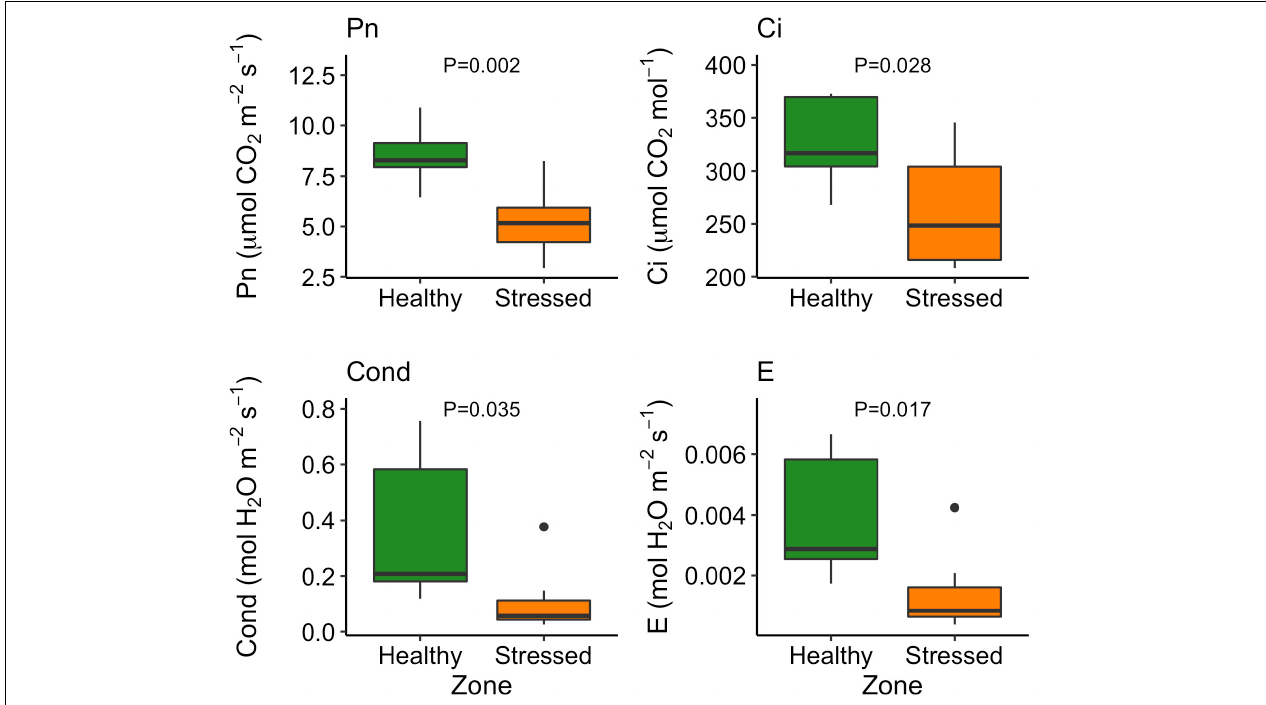
FIGURE 8 | Variation in photosynthetic rate (Pn), intracellular CO 2 concentration (Ci), stomatal conductance (Cond), and transpiration rate (E) between “stressed” and “healthy” Avicennia marina at the St Kilda mangrove forest, South Australia. The measurements were taken on the second youngest leaves. Four leaves were measured from each of seven plants per